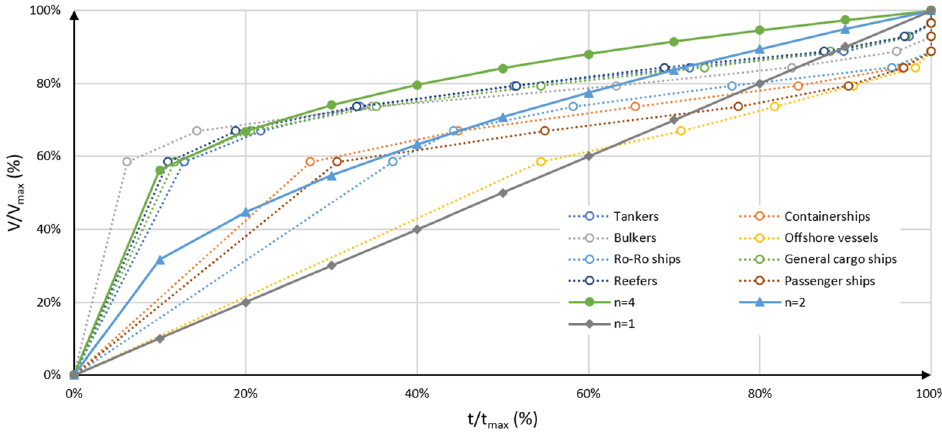
Figure 5. Comparison of generic and actual speed profiles for ocean-going ships.